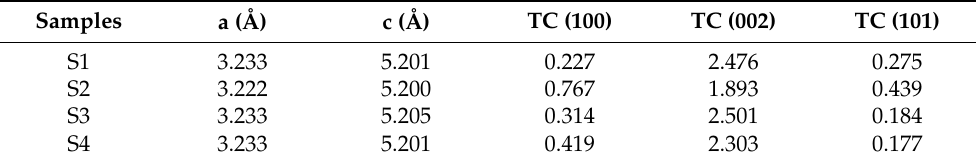
Table 2. Lattice parameters and texture coefficients of ZnO: F films.